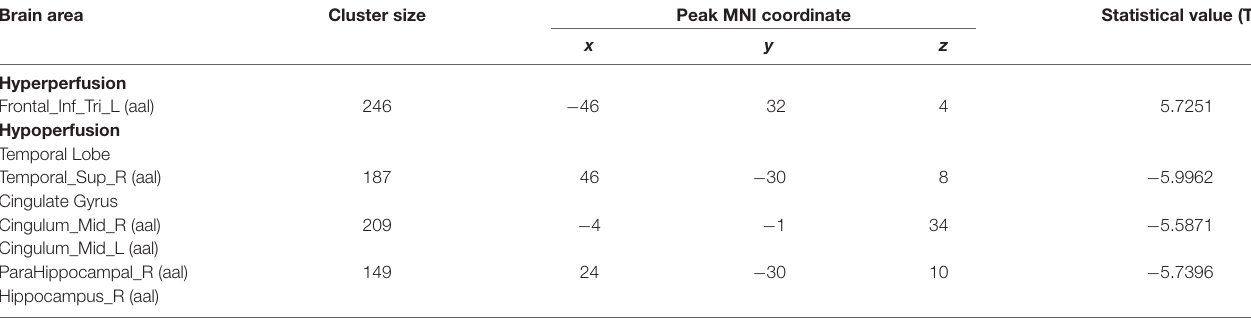
FIGURE 2 | Differences in cerebral blood flow (CBF) between the POCD and NPOCD groups. Voxelwise comparison of the partial volume corrected ASL revealed decreased CBF in the right superior temporal gyrus of the temporal lobe, right and left middle cingulate gyrus, and the right hippocampus and the parahippocampal gyrus, and increased CBF in the pars triangularis of inferior frontal gyrus in POCD patients compared with NPOCD patients. Voxel-based comparison superimposed onto Montreal Neurologic Institute standard brain in the coronal, axial, and sagittal planes. Due to the large cluster of brain regions corrected by multiple comparisons, space is limited to show all sections of brain regions, and only some brain regions with statistical differences are shown. There was no significant difference in the overlapping brain regions. Blue to red color indicates low to high blood flow. TABLE 4 | Areas of hypoperfusion and hyperperfusion in the POCD compared to the NPOCD group. Brain area Cluster size Peak MNI coordinate Statistical value